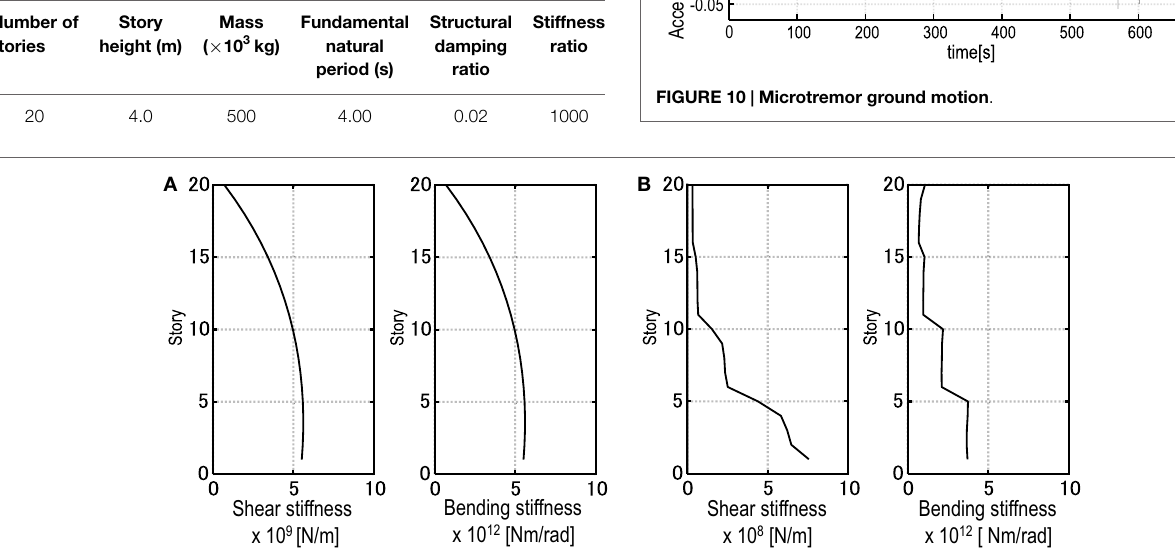
FIGURE 9 | Target distributions of shear and bending stiffnesses: (A) Model A and (B) Model B .